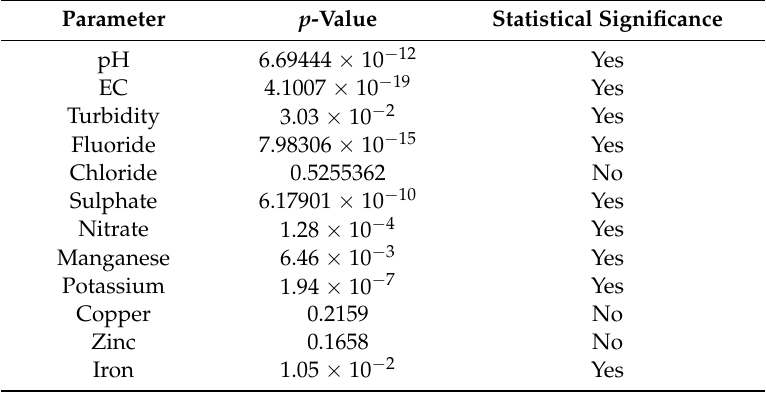
Table 3. Statistical significance based on single factor